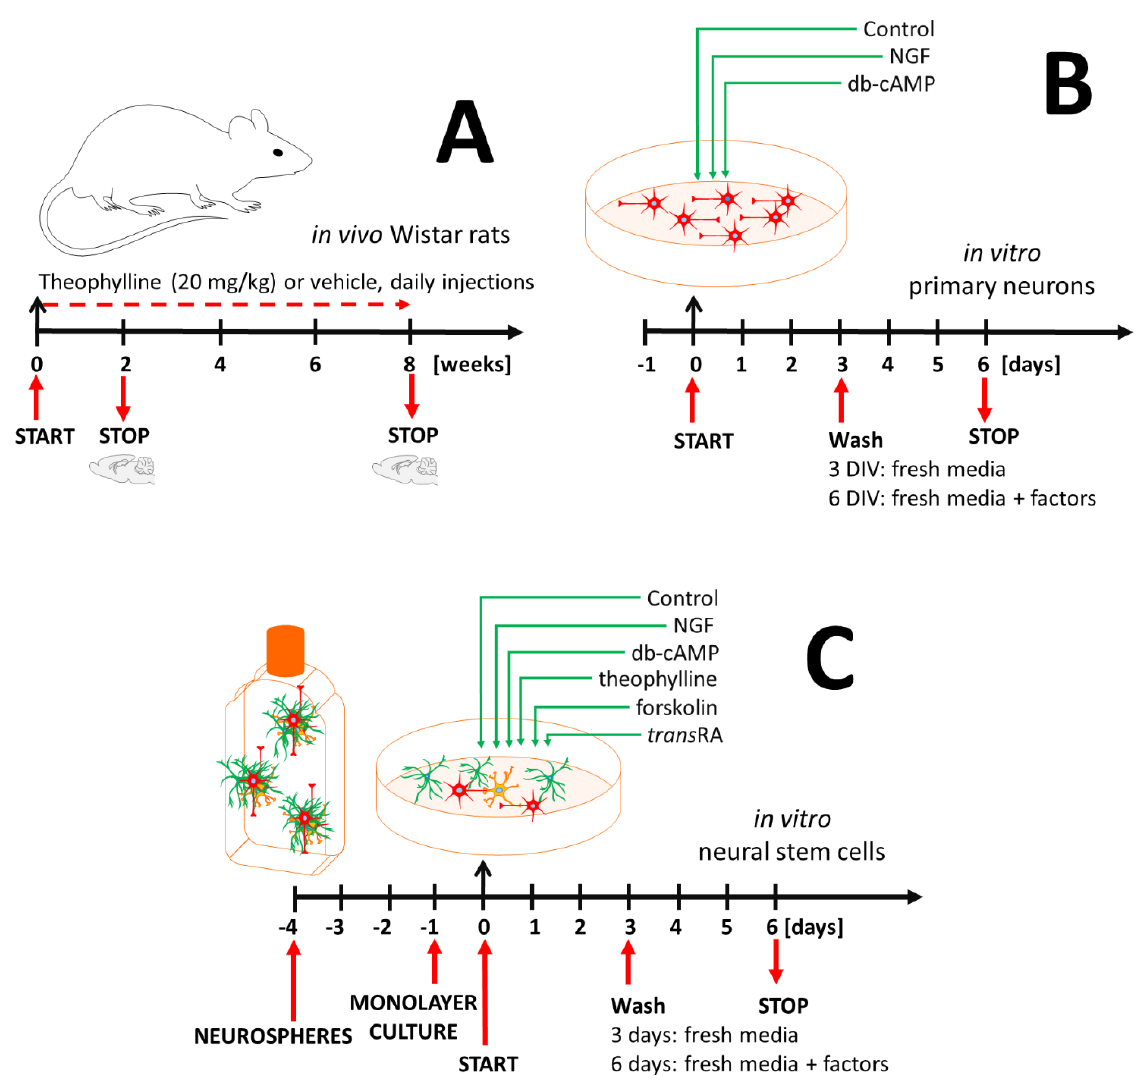
Figure 1. Experimental workflow: ( A ) Wistar rats challenged with theophylline (20 mg/kg b.w.) for 2 or 8 weeks; ( B ) primary neurons maturated with nerve growth factor or db-cAMP; ( C ) neural stem cells culture as neurospheres followed by monolayer culture and treated with maturation factors.